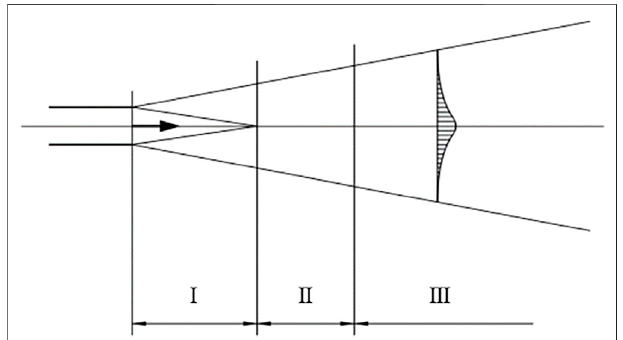
FIGURE 5 | Immersed free